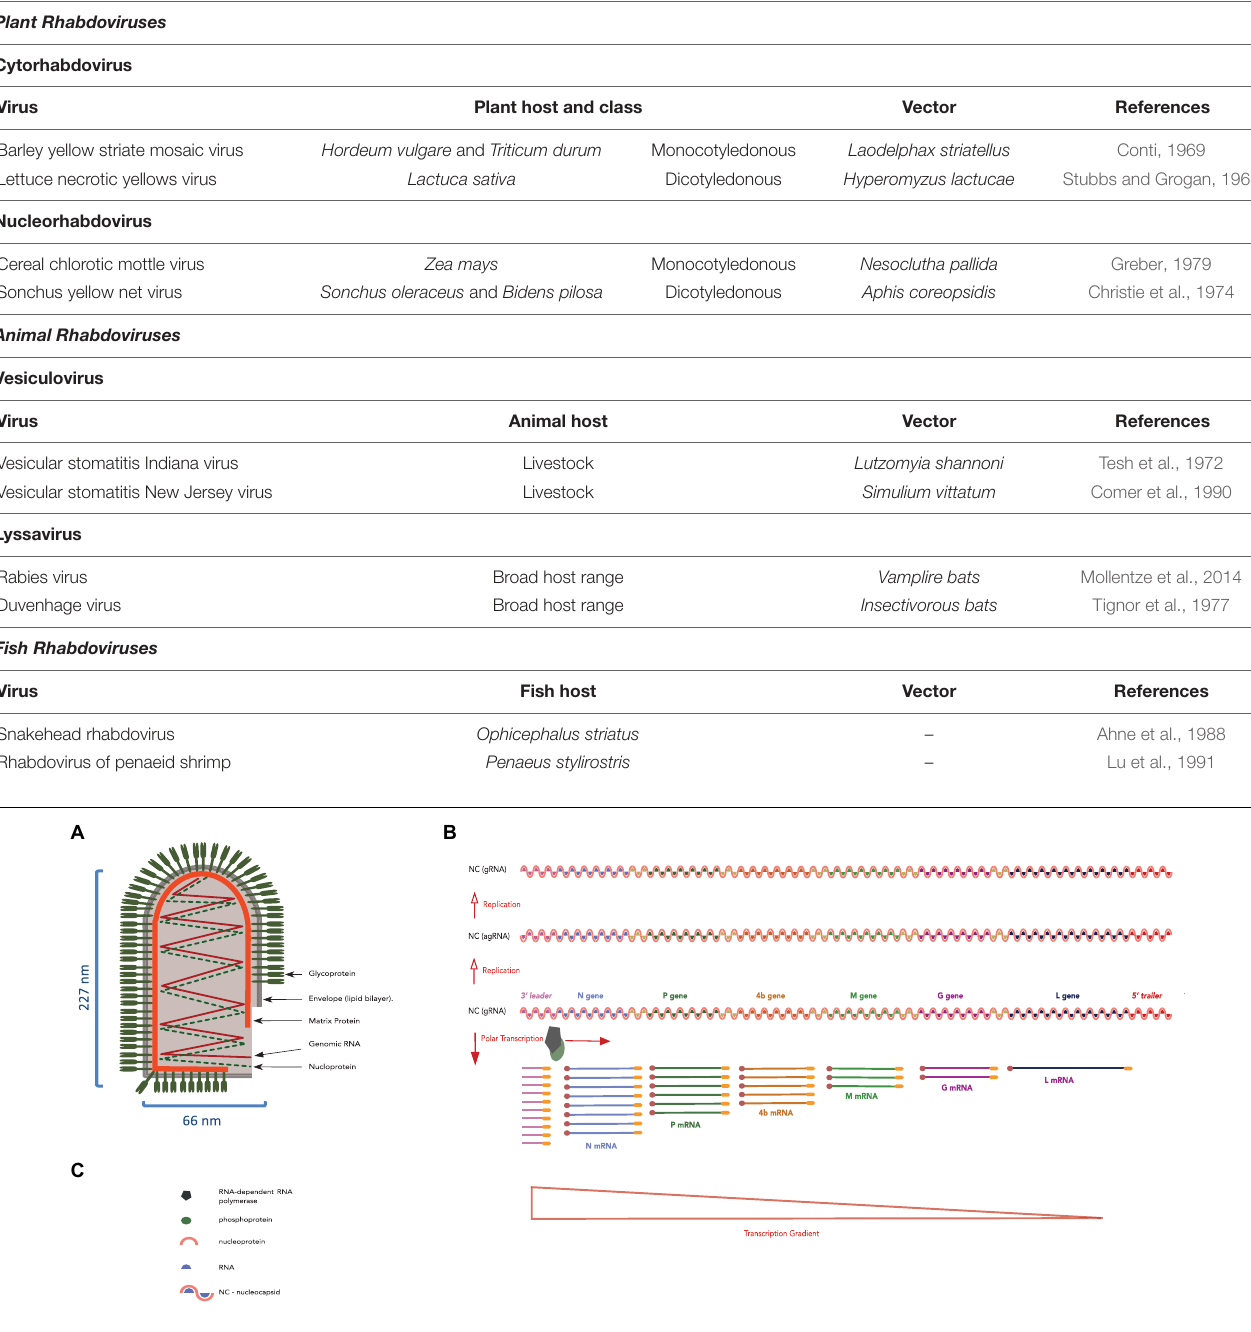
TABLE 4 | List of some rhabdoviruses including plant Cytorhabdoviruses and Nucleorhabdoviruses together with their host, host class, and vectors.